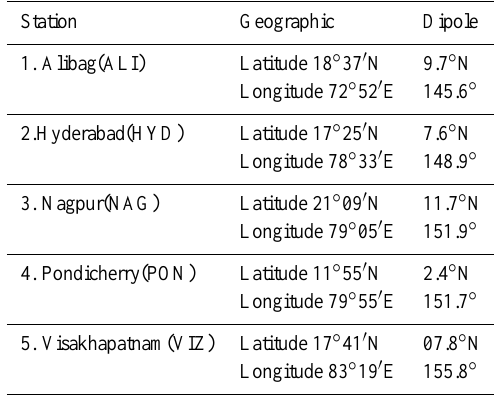
Table 1. Locations of